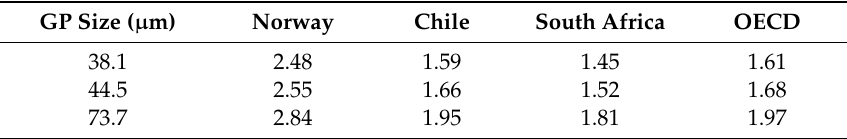
Table 9. SUB-RAW